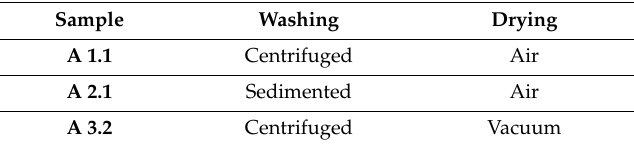
Table 1. SPIONs Samples Acronyms.